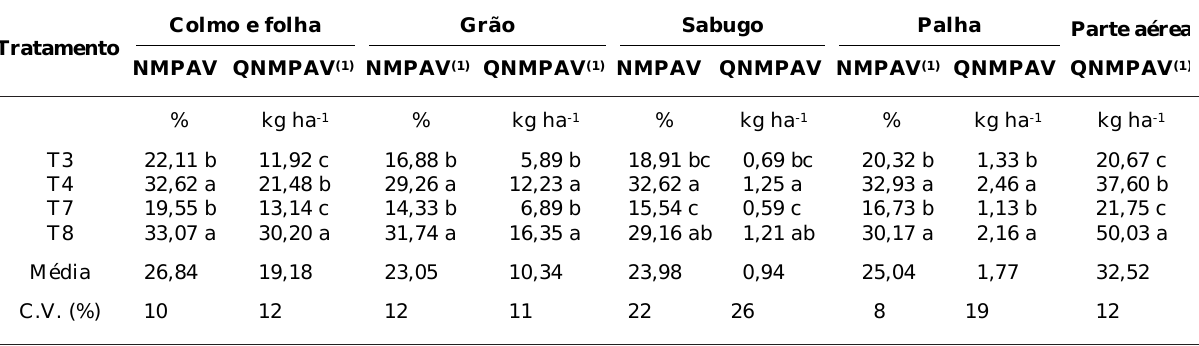
Quadro 6. Percentagens (NMPF) e quantidades (QNMPF) de nitrogênio no milho provenientes do fertilizante mineral, em amostragem realizada 85 dias após a